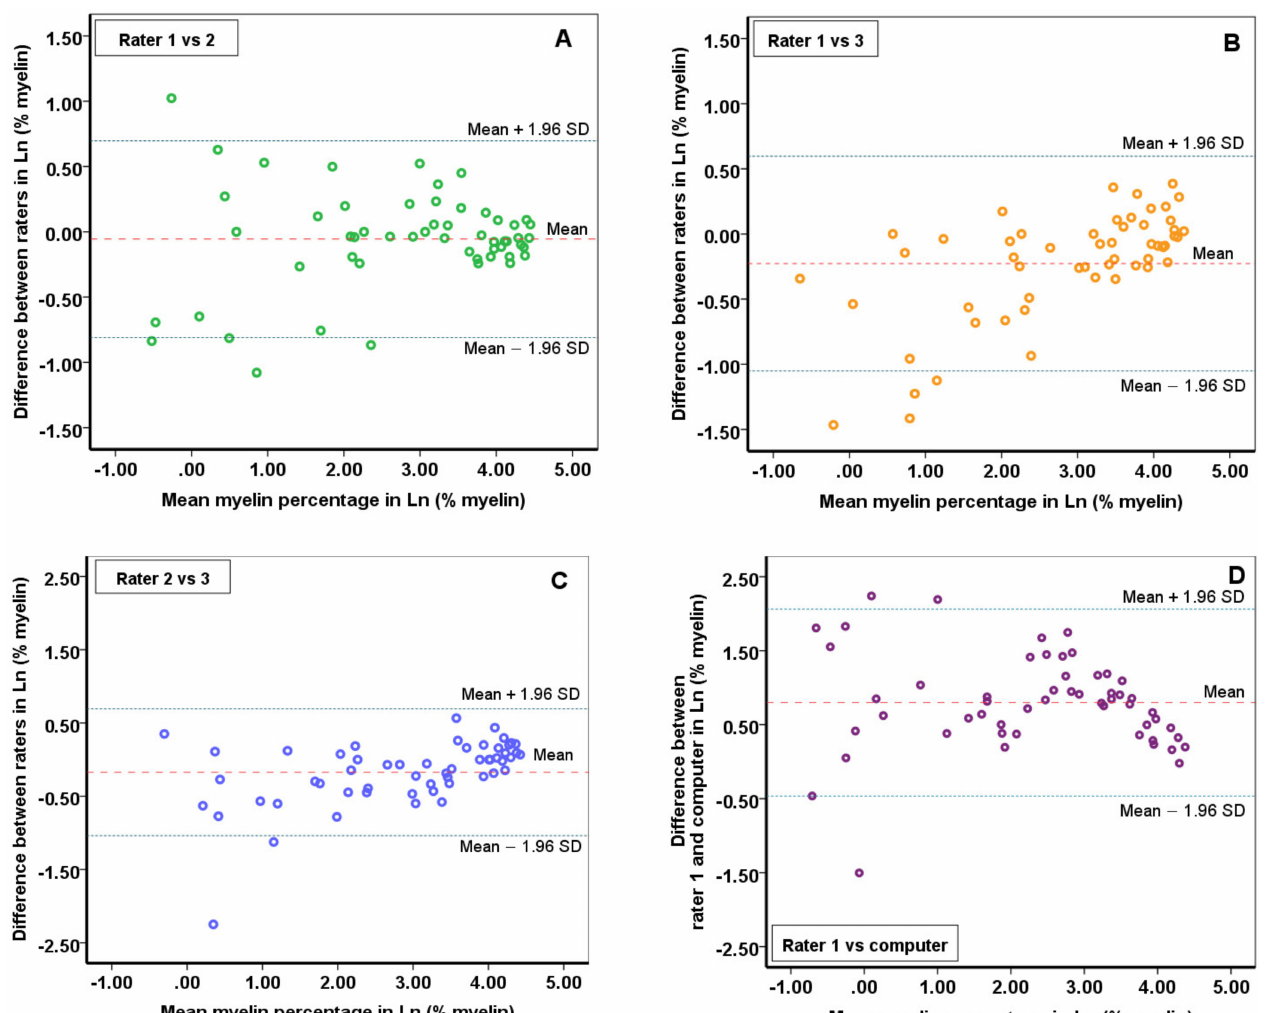
Figure 1. Bland-Altman plots showing inter-rater reliability between raters. ( A ) Showing inter-rater reliability between rater 1 and rater 2. It illustrates the mean difference (4.50% myelin) of measuring the myelin quantity, as well as the amount of scatter around the mean for each set of measurements (95% limit of agreement: − 3.85 to 12.85%) after log transformation; ( B ) Showing inter-rater reliability between rater 1 and rater 3. It illustrates the mean difference (5.53%) of the measured myelin quantity, as well as the amount of scatter around the mean for each set of measurements (95% limit of agreement: − 5.18 to 16.25%) after log transformation; ( C ) Showing inter-rater reliability between rater 2 and rater 3. It illustrates the mean difference (6.25%) of the measured myelin quantity, as well as the amount of scatter around the mean for each set of measurements (95% limit of agreement: − 5.93 to 18.43%) after log transformation; ( D ) Showing inter-rater reliability between rater 1 and the default-method of ImageJ. It illustrates the mean difference (14.29%) of the measured myelin quantity, as well as the amount of scatter around the mean for each set of measurements (95% limit of agreement: − 9.29 to 37.87%) after log transformation. Hence, the limit of agreements for the differences are in this figure illustrated in proportion to the mean